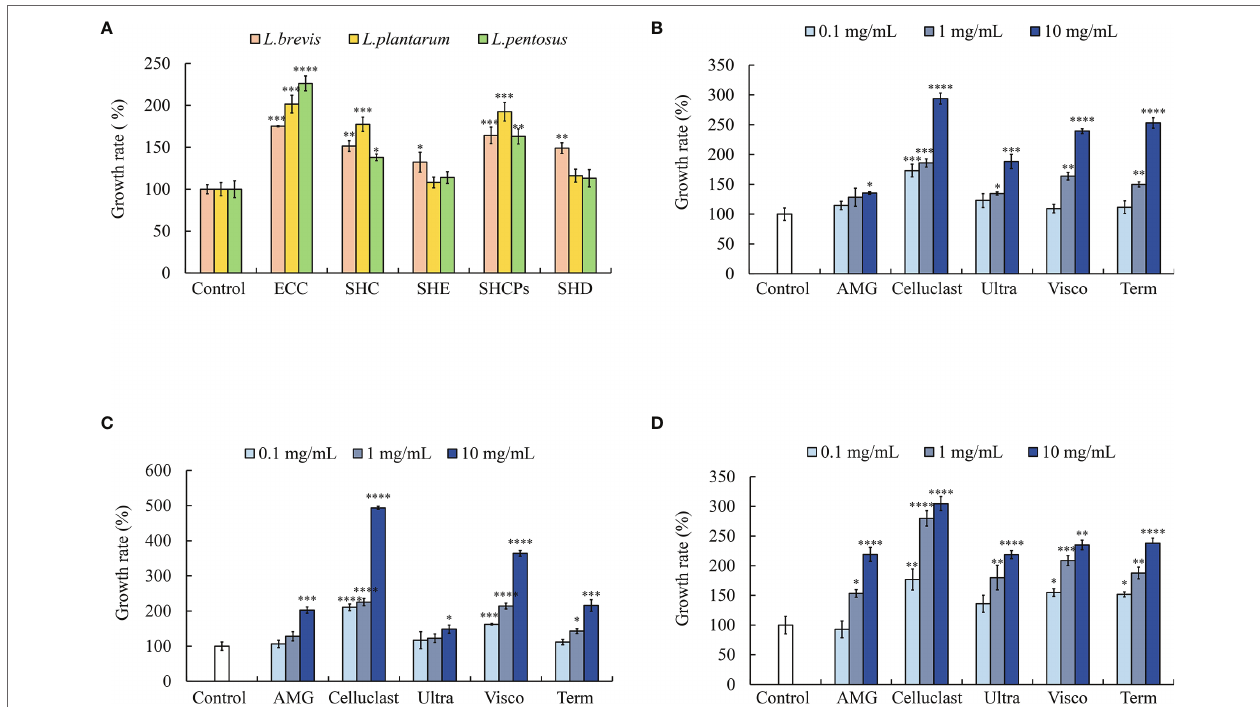
FIGURE 1 | Effect of SH extracts on lactic acid bacterial (LAB) growth. (A) Growth of LAB in different solvent extracts of SH. Growth of (B) L. plantarum , (C) L. pentosus , and (D) L. brevis in different enzymatic extracts of SH. Experiment was triplicated and statistical evaluation was performed by comparing experimental and control groups. Values are significantly different from the control group at *p<0.05, **p<0.01, ***p<0.005 and ****p<0.0001. (SHE, S. horneri ethanol extract; SHC, S. horneri Celluclast extract; SHCPs, S. horneri crude polysaccharide extract; SHD, S. horneri distilled water extract; ECC, Ecklonia cava Celluclast extract; AMG, S. horneri AMG enzymatic extract; Celluclast, S. horneri Celluclast extract; Ultra, S. horneri Ultraflo enzymatic extract; Visco, S. horneri Viscozyme enzymatic extract and Term, S. horneri Termamyl enzymatic